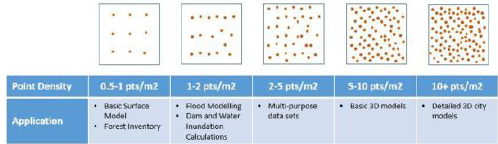
Figure 3. Common Point Densities (Felix,